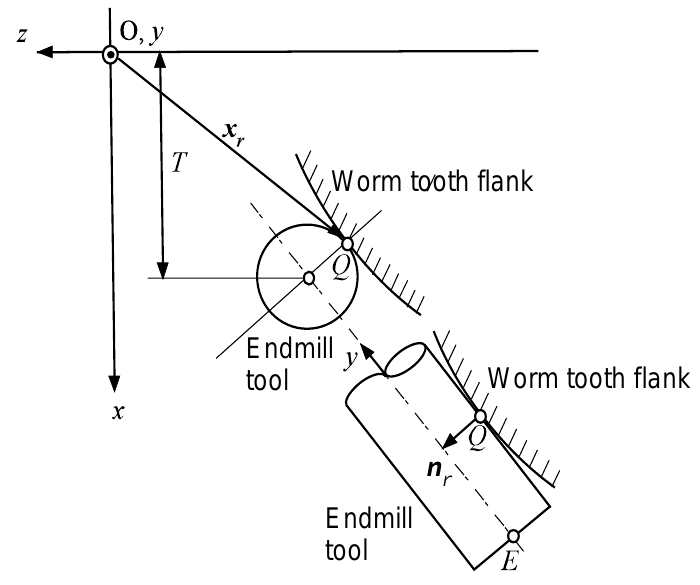
Figure 6. Offset-cutting method of worm.